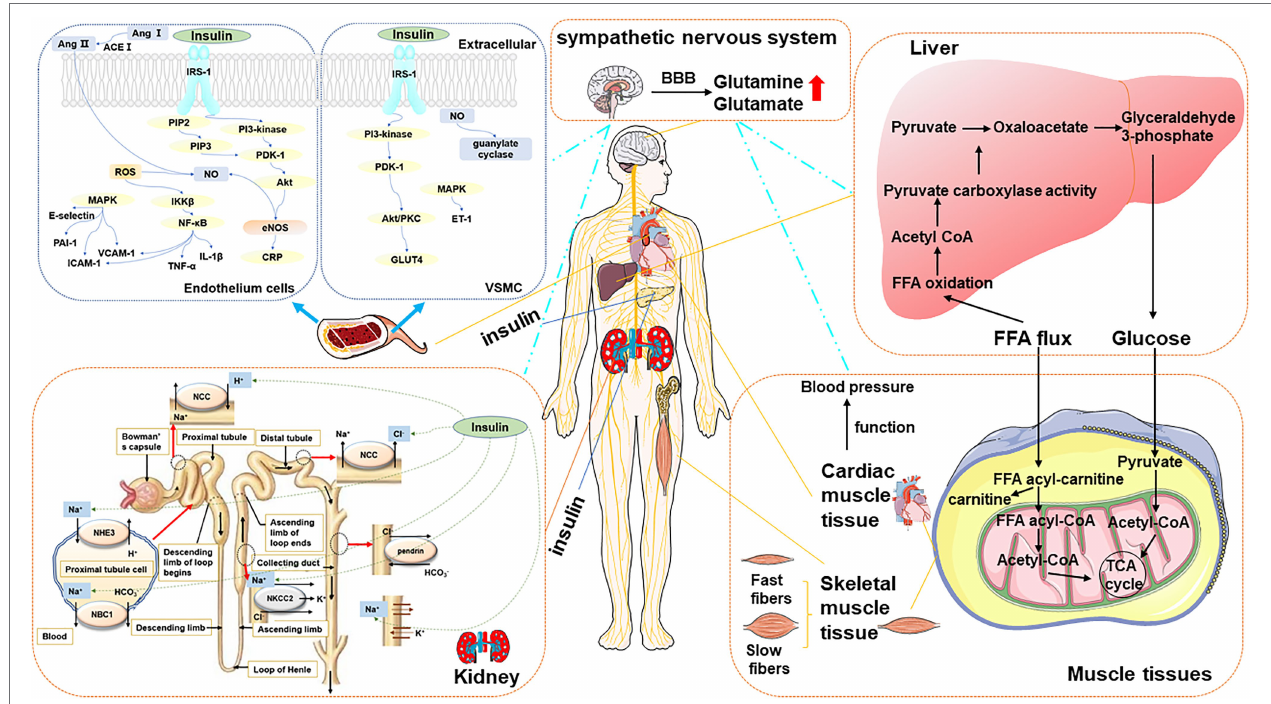
FIGURE 3 | The overview of type 2 DM-associated metabolic perturbations potentially involved in the pathogenesis of HTN. Blood vessel The left panel presented the mechanisms of HTN in DM in the endothelium cell. The mechanism started with IRS triggered activation of PI3K and the conversion from PIP 2 to PIP 3 . It allowed PDK-1 to access, leading to Akt activation. Akt increased eNOS activity and stimulated the production of NO. Meanwhile, Ang II and ROS are another way to produce NO. MAPK-dependent insulin signaling pathways tend to promote pro-HTN insulin metabolite. It inhibits PAI-1, E-selection, ICAM, and VCAM. The right panel presented the mechanism of HTN in DM in VSMC. The increased blood flow further facilitates glucose uptake by provoking insulin-responsive GLUT4 translocation in PI3K-dependent metabolic actions. MAPK-dependent insulin signaling pathways tend to promote ET-1. The production of NO is related to guanylate cyclase. Kidney The sodium-chloride cotransporter (NCC) has the function of reabsorbing sodium and chloride ions from the tubular fluid. Insulin promotes the resorption of chloride ions. Insulin stimulates the NHE3 on the apical membrane and upregulates the NBC1 on the basolateral membrane. In the thick ascending limb of Henle, insulin stimulates NaCl reabsorption by activating NKCC2 and Na-K-ATPase. The sodium and bicarbonate were reabsorbed. Insulin can also stimulate the Na-K-ATPase in the proximal tubule in the proximal tubule. Liver and muscular tissue FFA is the major oxidation fuel for muscular tissue, such as cardiac muscle tissue and skeletal muscle tissue, while glucose provides the remaining need. The transformation of cardiac function metabolites affects the function of the heart, which is closely related to blood pressure. The balance of FFA and glucose results in the transformation of two muscle types: slow-twitch myofibers and fast-twitch fibers. Sympathetic nervous system It controls peripheral organs, including the liver, skeletal muscle, pancreas, vascular and cardiovascular system resulting in glucose disorder, insulin resistance, insulin secretion impairment, and blood pressure increase, which are predicted to chronically contribute to the development of DM and